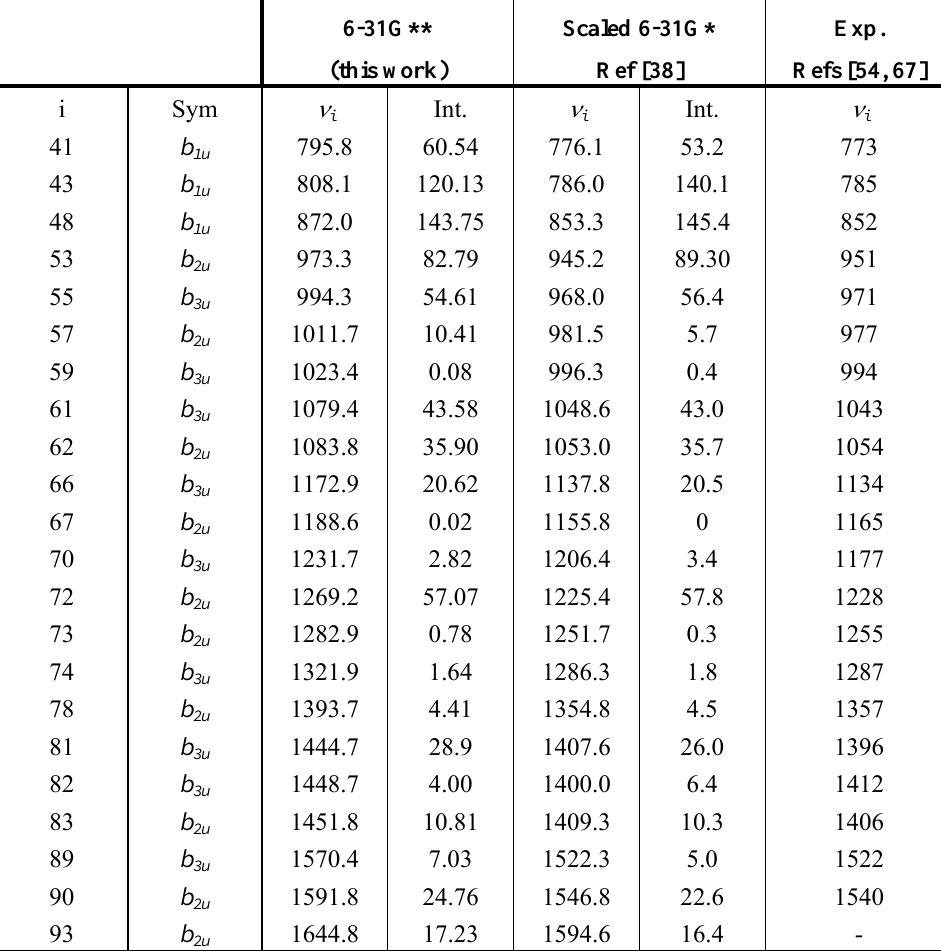
Table 3. The part of the infra-red spectrum of free-base porphyrin in the region 760 – 1,750 cm -1 . “Int.” is the IR absorption intensity (km/mol), “ 